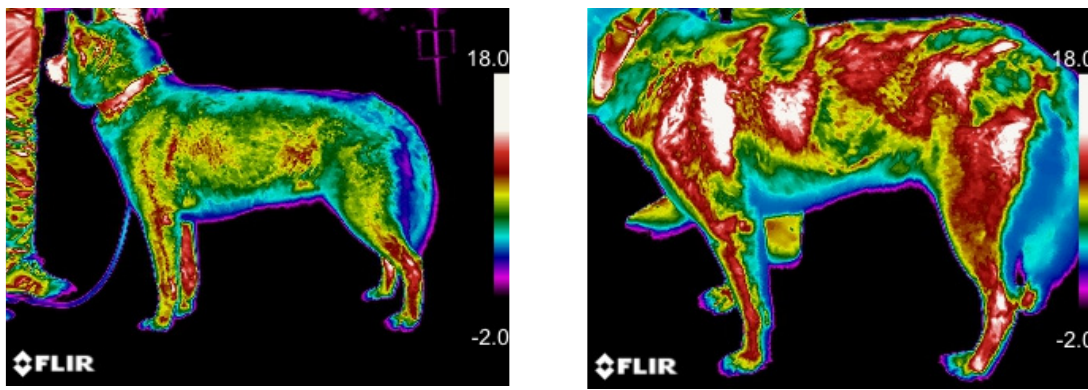
Figure 4. Five-year-old, female, Siberian Husky dog. Comparison of macroscopic thermographic aspect of left lateral view of the body surface before (T0) and after competition (T1). The brighter colors (red, orange, and yellow) indicate warmer temperatures (more heat and infrared radiation emitted), while the purples and dark blue/black indicate cooler temperatures (less heat and infrared radiation emitted). -2.0 = − 2.0.